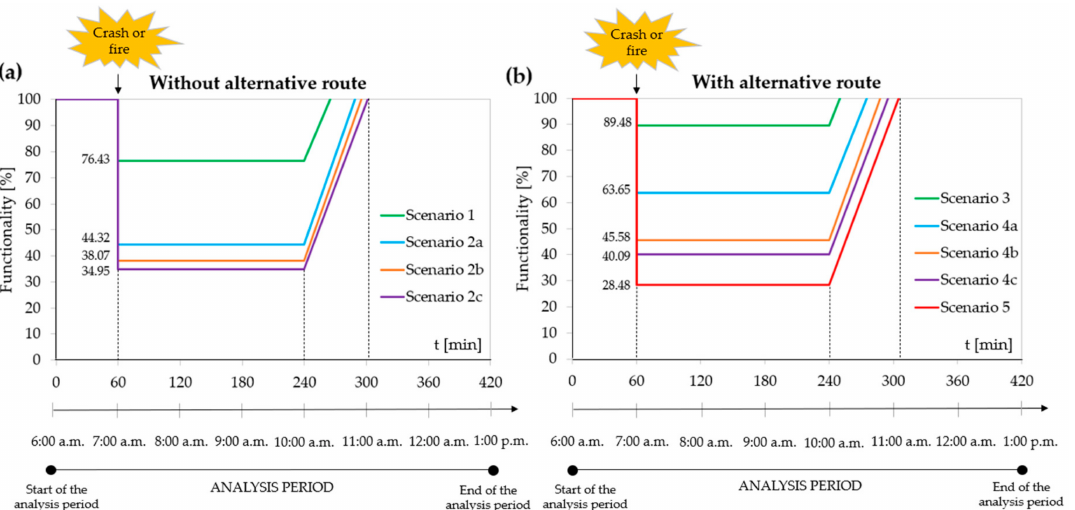
Figure 9. Functionality recovery curve of both the motorway section containing the tunnel tube investigated and the corresponding road network for the partial or complete closure of the north tube equal to 3 h: ( a ) without alternative route, ( b ) with alternative route. Scenario 1: partial closure of the north tube (only one lane is closed); Scenario 2: complete closure of the north tube and use of the adjacent one for bi-directional traffic with the traffic by-pass opening within 10 min (Scenario 2a), 20 min (Scenario 2b), and 30 min (Scenario 2c), respectively; Scenario 3: partial closure of the north tube with alternative itinerary used by HGVs only; Scenario 4: complete closure of the north tube and use of the adjacent one for bi-directional traffic with alternative itinerary used by HGVs only, and traffic by-pass opening within 10 min (Scenario 4a), 20 min (Scenario 4b), and 30 min (Scenario 4c), respectively; Scenario 5: complete closure of the north tube with alternative itinerary used by all the